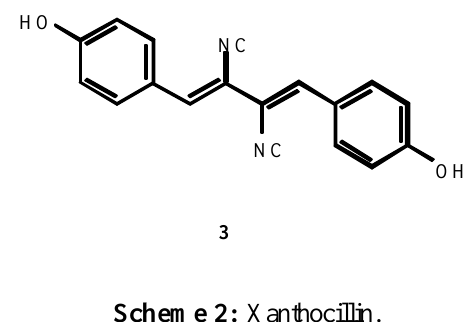
Scheme 2: Xanthocillin.